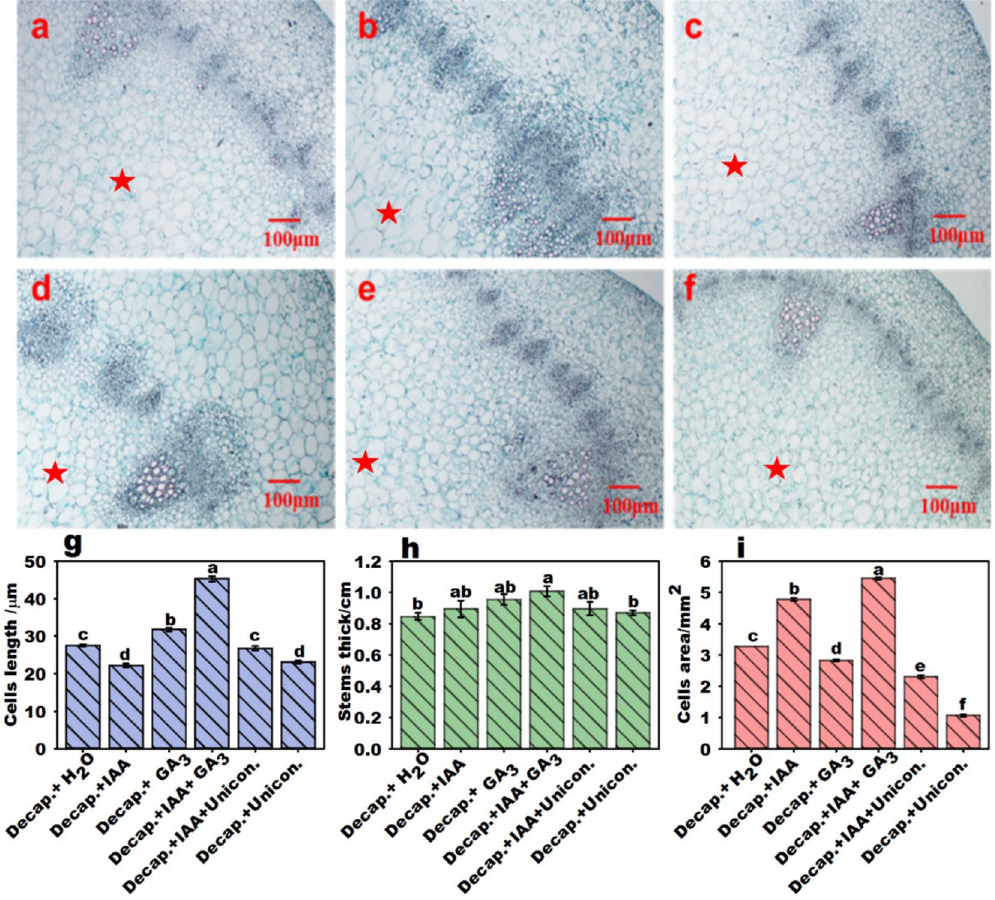
Figure 4. Stalk thickness and cell growth in flowering Chinese cabbage stalk tips following different treatments. Pictures show the pith cell microstructures of decapitated plant stalks in transverse sections: ( a ) decapitation + H 2 O, ( b ) decapitation + IAA, ( c ) decapitation + GA 3 , ( d ) decapitation + IAA + GA 3 , ( e ) decapitation + IAA + uniconazole, ( f ) decapitation + uniconazole. The stalk pith region was marked with a star ). ( g ) Cell length from longitudinal sections of flowering Chinese cabbage stalks. ( h ) Diameter of stalk tips. ( i ) Cell area from transverse sections of flowering Chinese cabbage stalks. Values with different letters indicate ★ significant differences at p < 0.05, according to Duncan’s multiple range tests. Error bars indicate standard